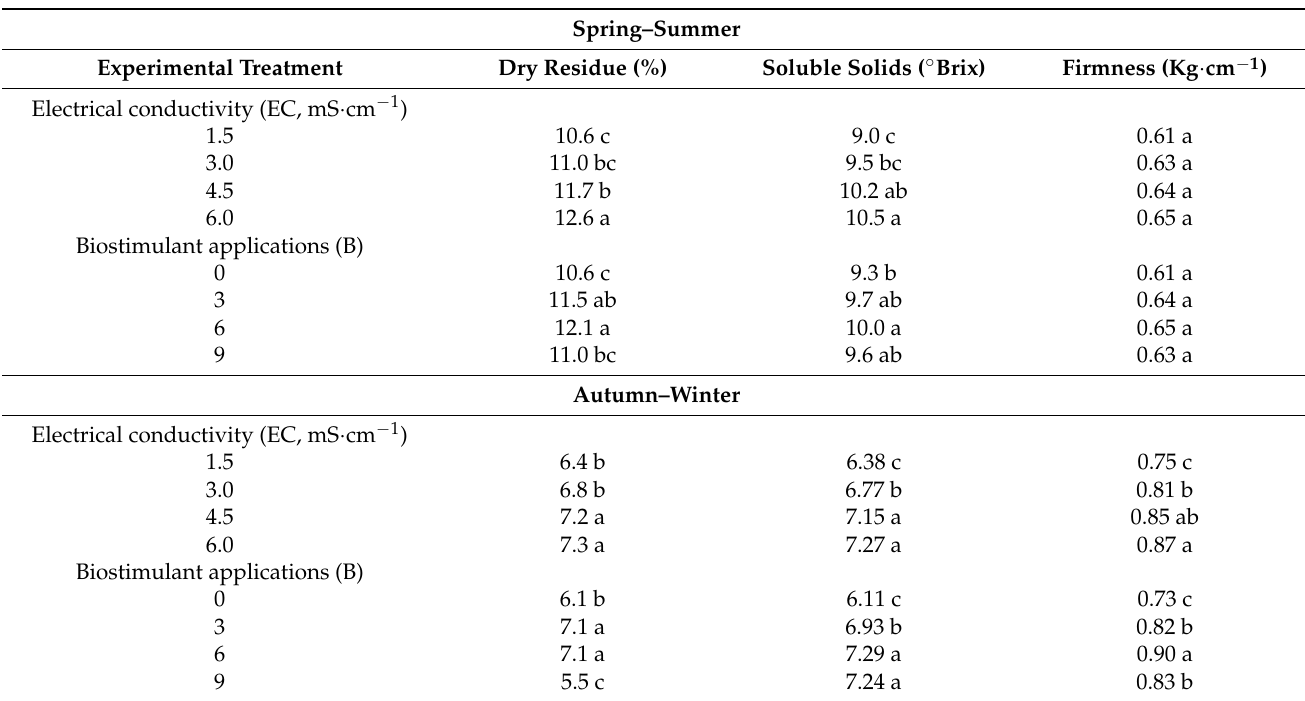
Table 2. Quality features of tomato fruits as affected by soil EC and the number of biostimulant